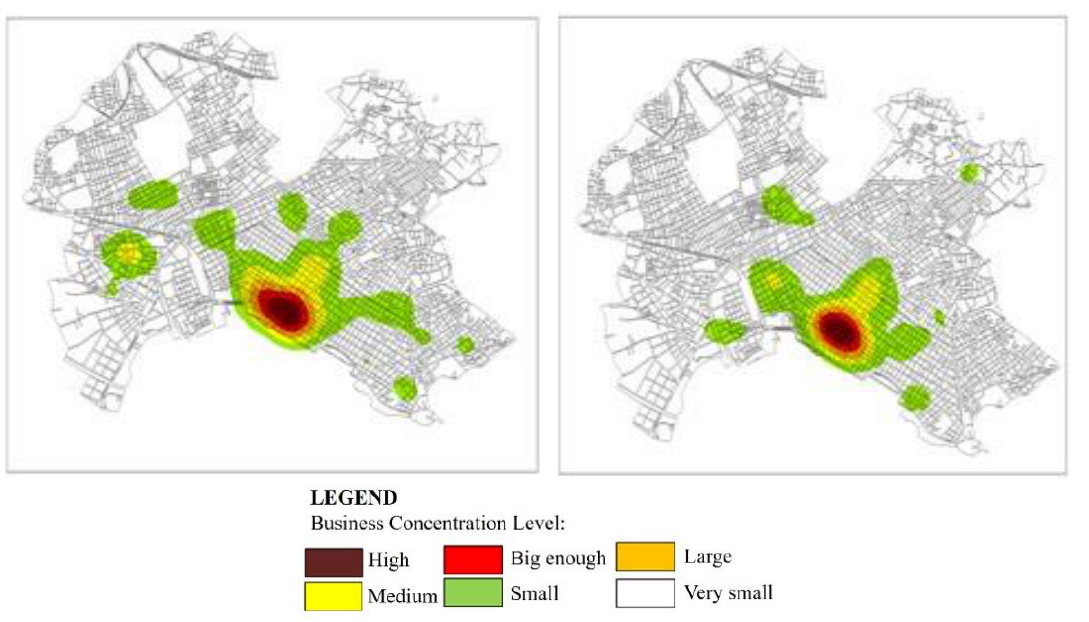
Figure 6 . Kernel density for the years 2008 – 2018 for companies closed in the respective years, Source: Figure 6. Kernel density for the years 2008–2018 for companies closed in the respective years, Source: Chamber of Magnesia, Own processing. Chamber of Magnesia, Own